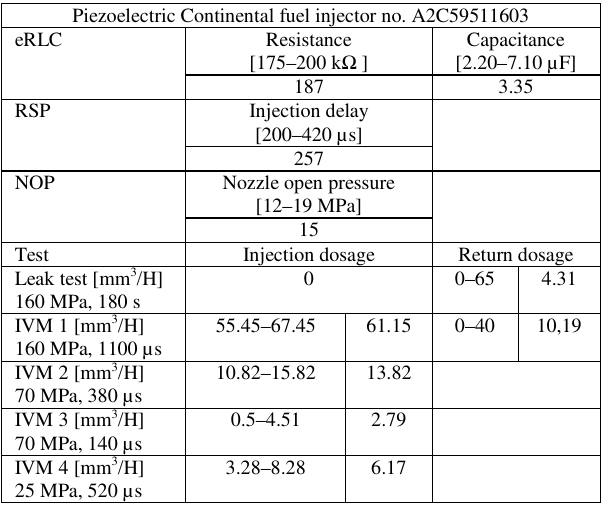
Table 9. Test results of faultless piezoelectric Continental fuel injector research Piezoelectric Continental fuel injector no. A2C59511603 eRLC